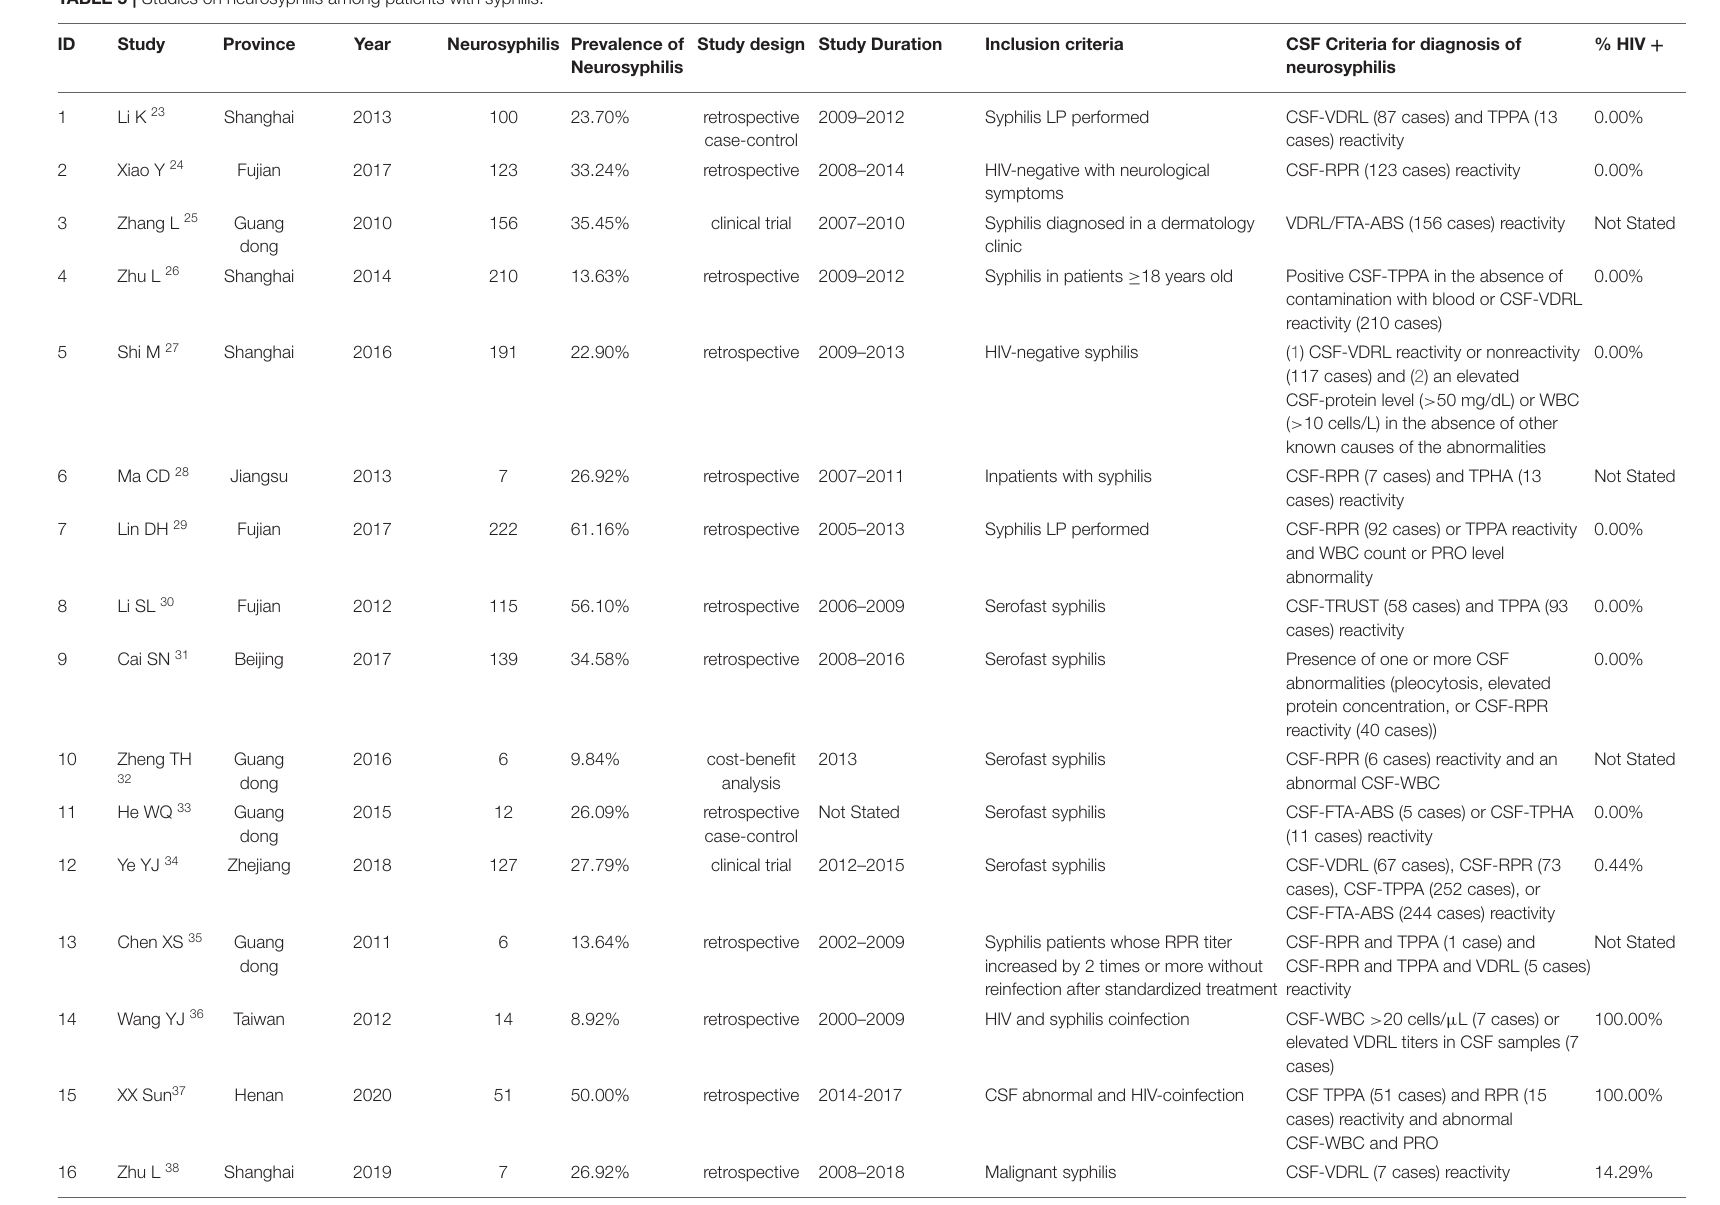
TABLE 5 | Studies on neurosyphilis among patients with